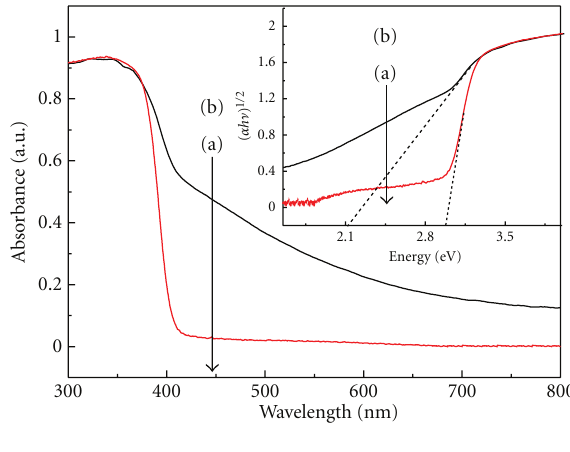
Figure 4: UV-vis DRS of the pure (a) and N-Cl-codoped (b) TiO 2